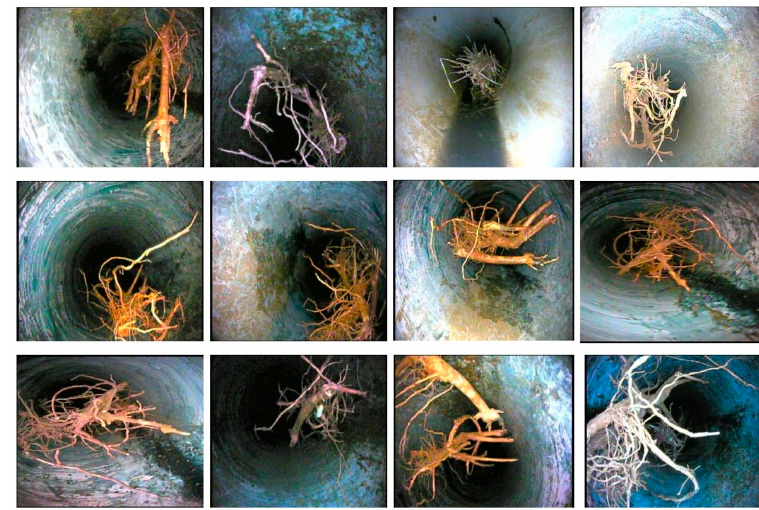
Figure 5. Tree root blockage frames in the S-BIRD dataset.